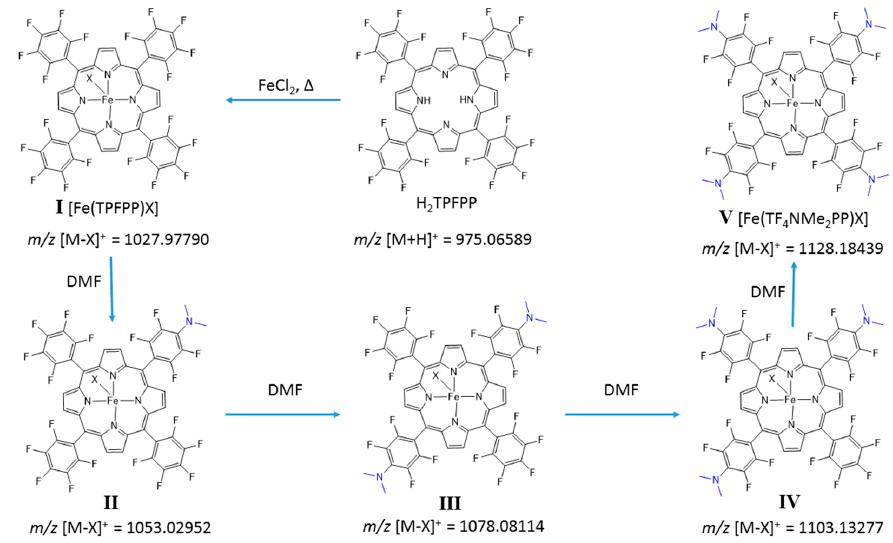
Figure 4. Complexes of [Fe(TPFPP)X] obtained during metalation reactions by heating DMF and pyridine mixtures for long reaction periods.